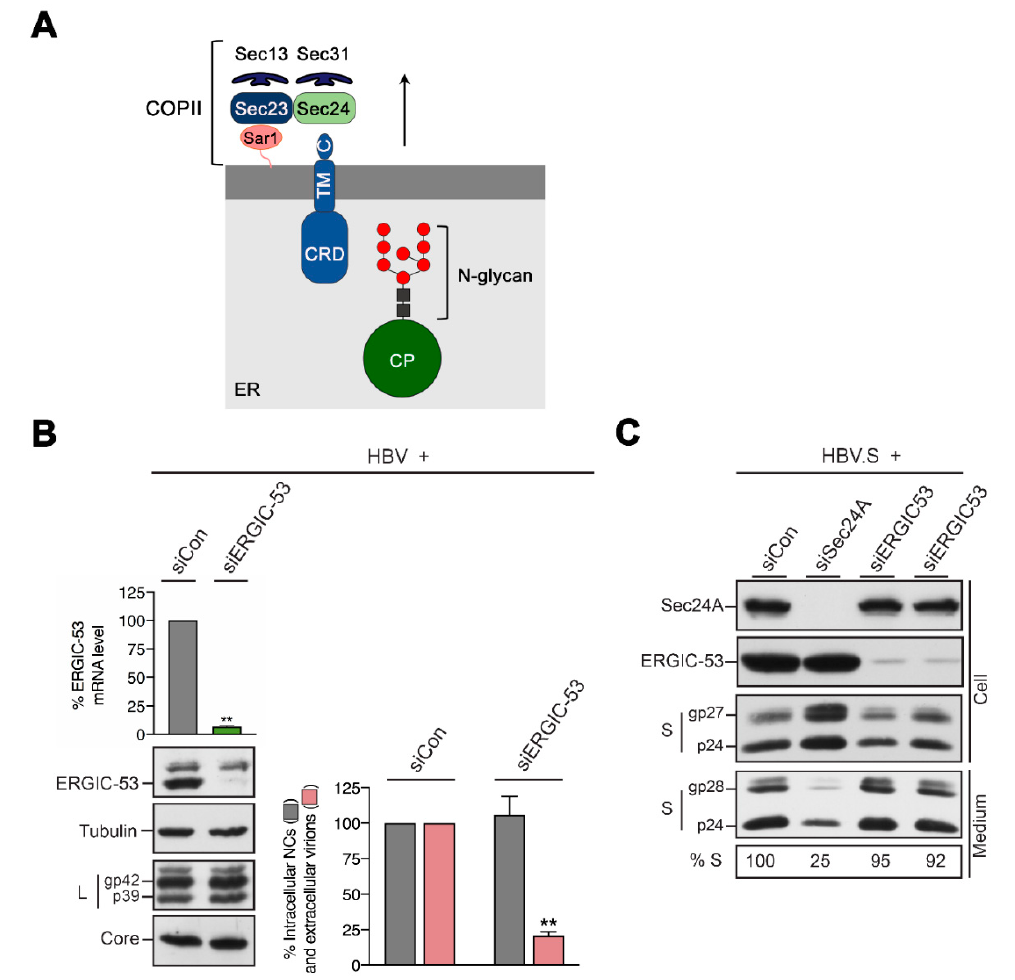
Figure 5. ERGIC-53 controls the egress of HBV viral particles but not of HBV spherical subviral particles. ( A ) Model depicting the structure of ERGIC-53 in association with cargos and COPII. ERGIC-53 is a type I integral membrane protein with a C-terminal transmembrane domain (TM) and a luminal cargo recognition domain (CRD) interacting with N-linked high-mannose glycans of cargo proteins (CP) within the ER. Its cytoplasmic ER exit motif ( C ) binds to Sec24, the cargo adaptor of COPII. GTP activation of Sar1 leads to the formation of the Sec23 / 24 heterodimer, cargo capture and coat polymerization by the Sec13 / 31 complex. ( B ) The treatment of HuH-7 cells with the control (siCon) or ERGIC-53-specific siRNAs for 2 days and retransfection with the HBV* replicon construct for an additional 3 days. The degree of ERGIC-53 depletion was measured by qRT-PCR of the transcript levels and WB analysis. Cellular lysates and supernatants were subjected to tubulin-, L- and core-specific WB and to the virion production assay ( n = 3, ± SD). ( C ) Treatment of HuH-7 cells with control (siCon), Sec24A- or ERGIC-53-specific siRNA duplexes for 3 days and retransfection with an haemagglutinin (HA)-tagged S construct (HBV.S) for an additional 2 days. The ERGIC-53-specific RNAi experiments were done in duplicate. To monitor depletion, cell lysates were examined by Sec24A- and ERGIC-53-specific WB. Cell lysates (Cell) and concentrated cell supernatants (Medium) were probed by anti-HA immunoblotting. The nonglycosylated (p24) and glycosylated (gp27 and gp28) forms of HBV.S are depicted.